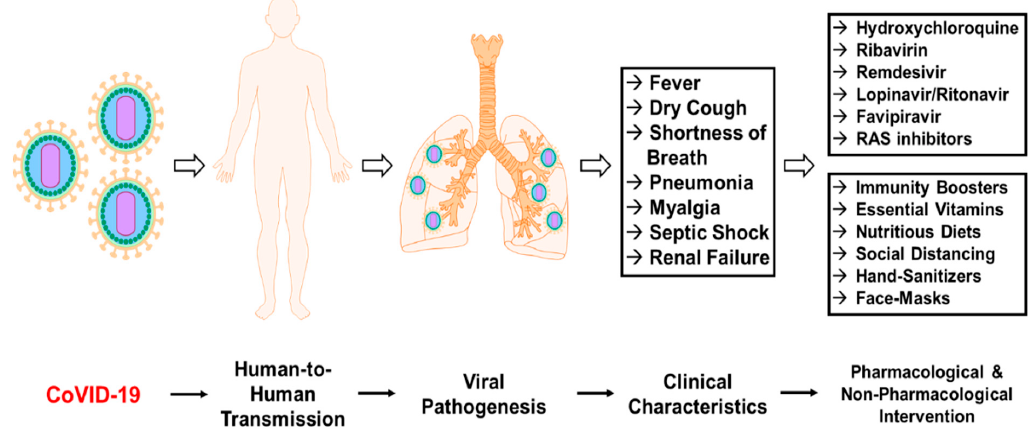
Figure 1. Schematic representation for pathogenicity of novel coronavirus disease (CoVID-19) in humans. The viral transmission through human-to-human induces systemic effects and targets lungs causing clinical manifestation of symptoms associated with the virus that have been persistent in patients affected with CoVID-19. The pharmacological and non-pharmacological intervention strategies may mitigate these effects and assist in viral containment.